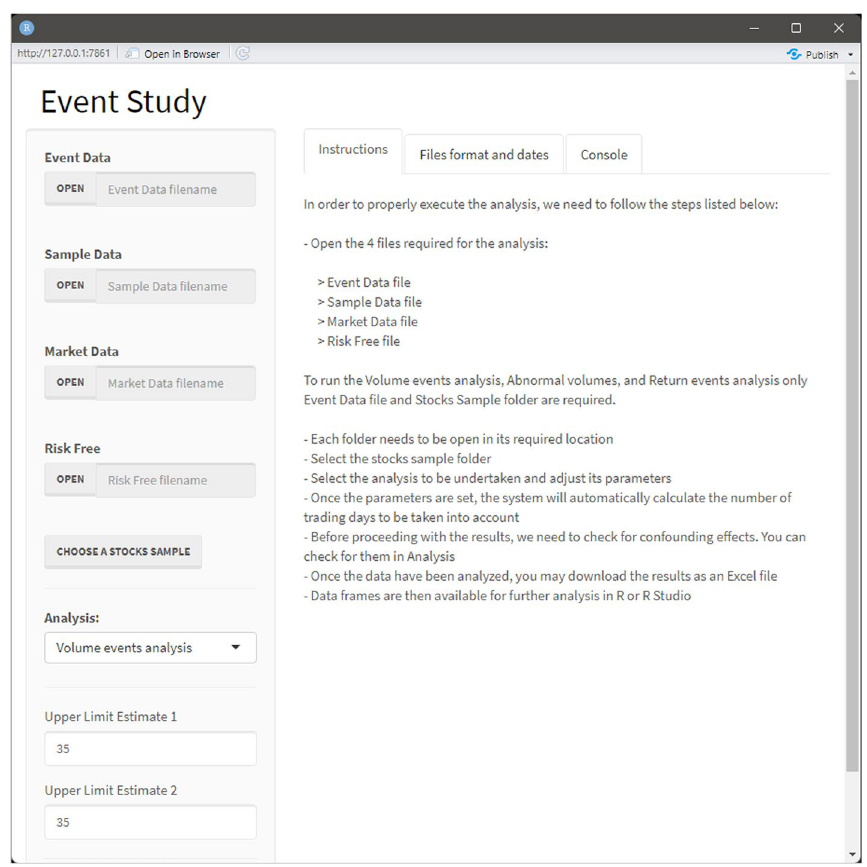
Fig. 14 Dashboard interface. Source : Created by